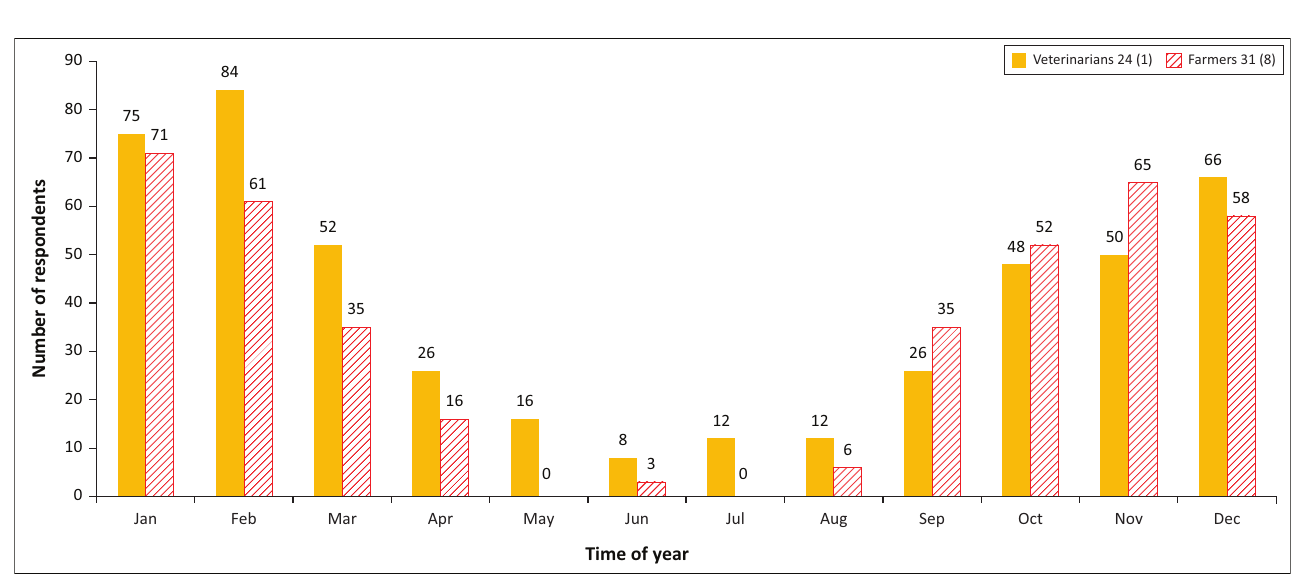
FIGURE 1: Months of the year where heartwater incidence appears to be the